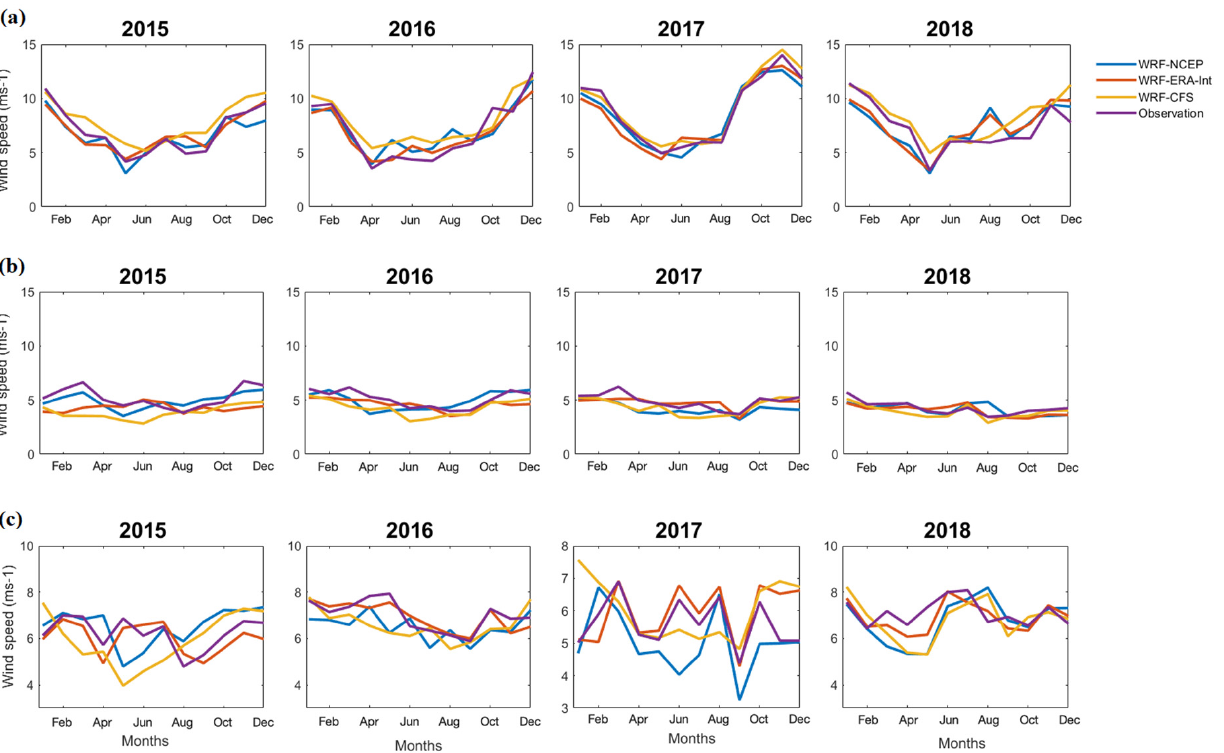
Figure A6. Monthly averaged wind speed in m s − 1 from the models and observations at the offshore locations ( a ) Quanzhou, ( b ) Shanwei, and ( c ) Nansan.